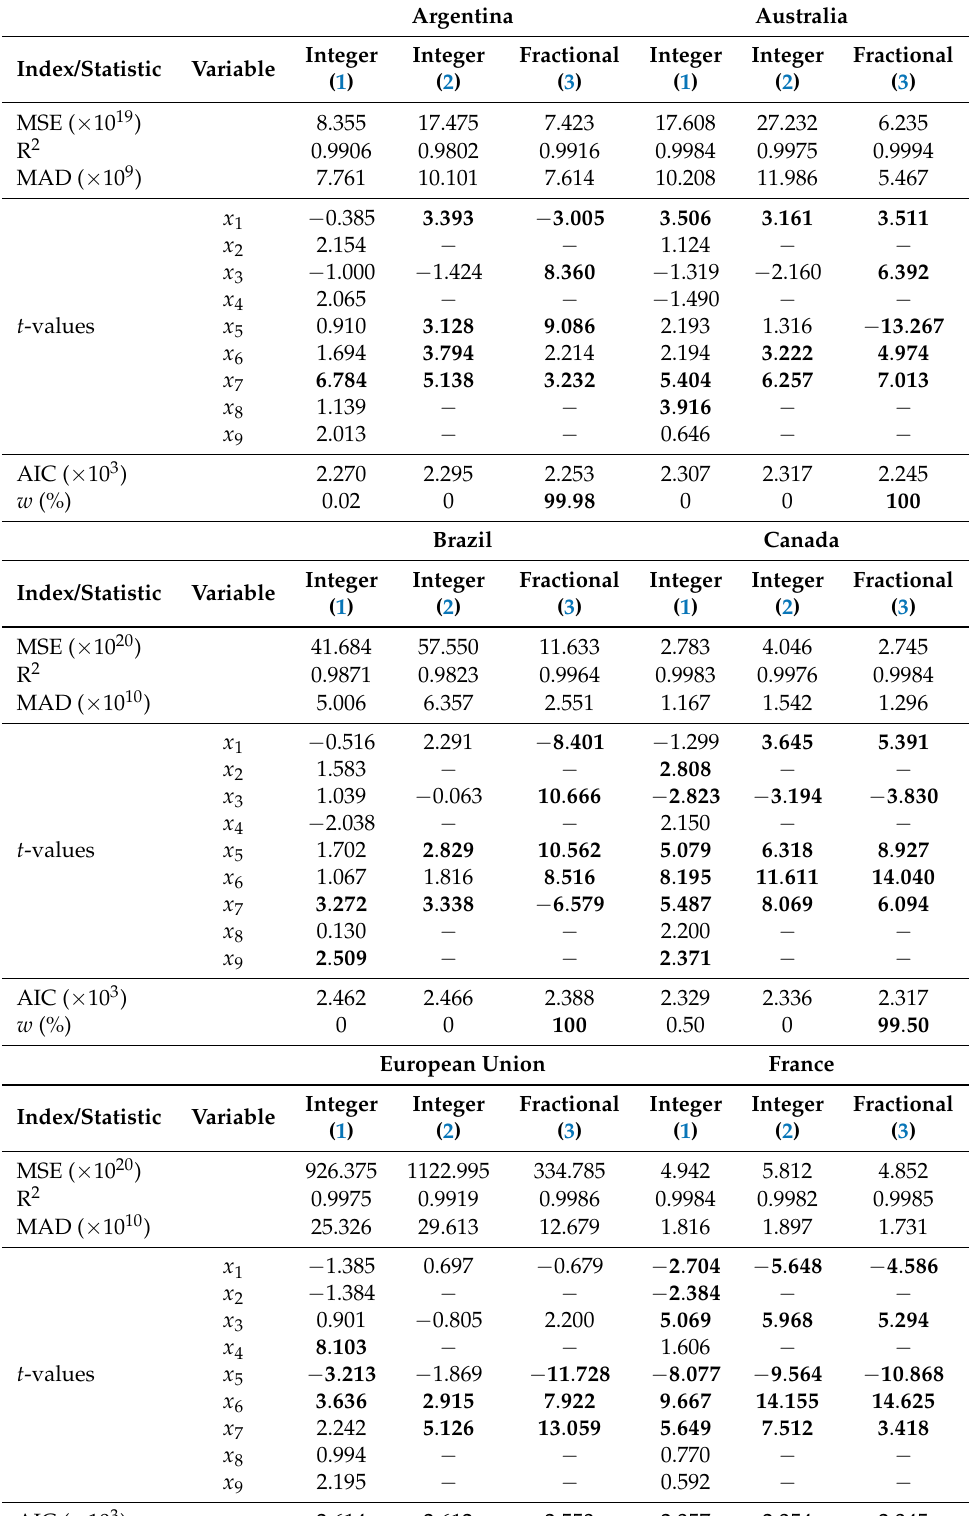
Table 1. Performance indices of the different models obtained for the G20 members in Figure 2; for an explanation of performance assessment see Section